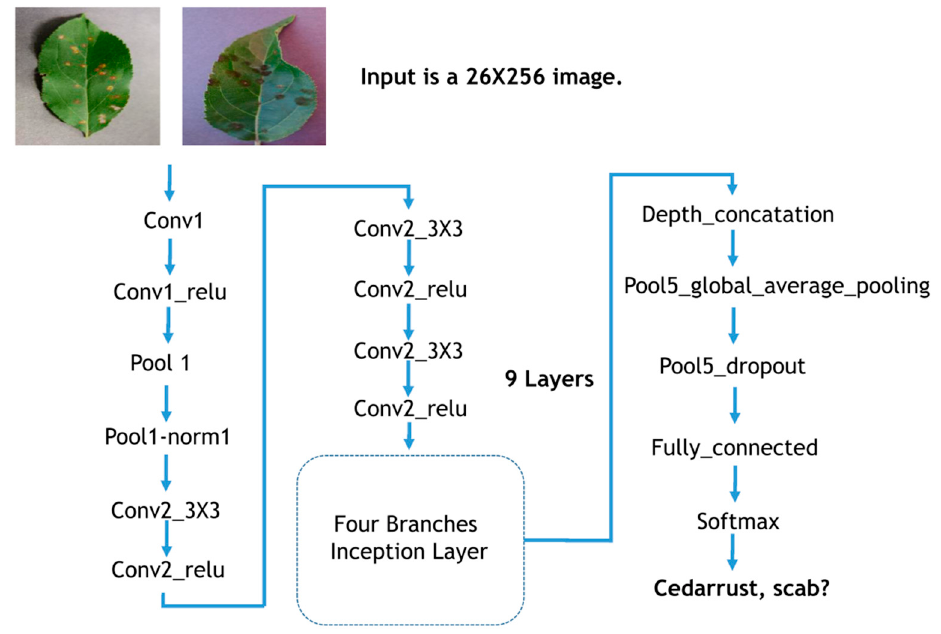
Figure 7. Google inception convolution neural network architecture for image classification training using the apple pa- thology dataset. Conv2_3 × 3 represents the second stage, 3 × 3 convolution filter.